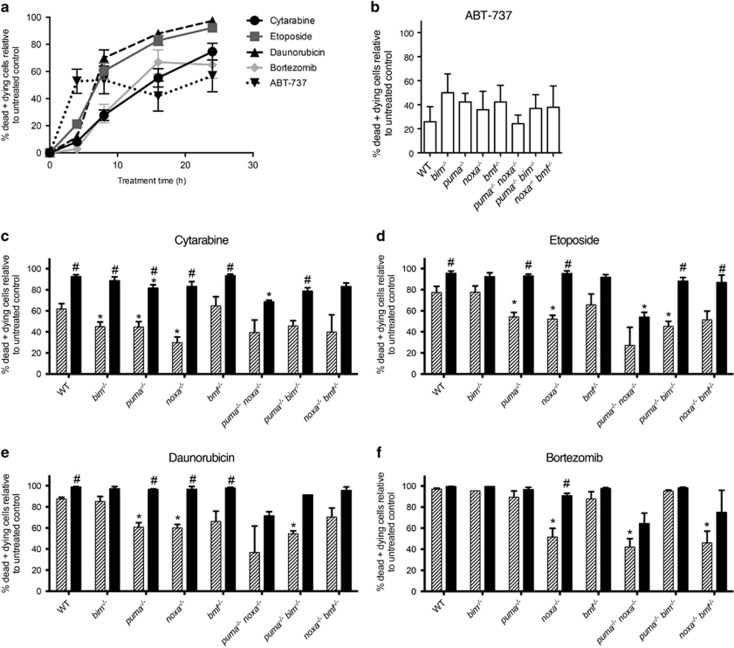
In vitro sensitivity of MLL-AF9 AML cell lines to cytotoxic agents. Drug sensitivity tests were performed using short-term cell lines established from bone marrow of sick primary MLL-AF9 AML mice (Materials and methods section). (a) WT/MLL-AF9 AMLs (n=4) were treated with standard chemotherapeutic drugs cytarabine (300 ng/ml), etoposide (300 ng/ml), daunorubicin (50 ng/ml), bortezomib (5 nM) or BH3 mimetic ABT-737 (1 μg/ml), harvested at 4, 8, 16 and 24 h and analyzed by flow cytometry following staining with annexin V-Alexa Fluor 647 and propidium iodide (dying and dead cells are positive for annexin V or both markers). Results are expressed as percentage of dead and dying cells relative to that of cells cultured in parallel in medium alone. Value shown is mean±S.E.M. (b–f) AMLs of the indicated genotypes were cultured for 16 h in the presence of ABT-737 alone (b); or with cytarabine (c), etoposide (d), daunorubicin (e) or the proteasome inhibitor bortezomib (f), each alone (gray) or in combination with ABT-737 (black). The percentage of dead and dying cells is expressed relative to cells of the same genotype incubated in the absence of drug(s). Values represent mean±S.E.M. Data plotted for ABT-737 alone were pooled from all experiments (n=8 independent lines for WT and n=2–6 independent lines for other genotypes). The number of independent lines used for other drugs±ABT-737 were: WT n=5; bim−/−
n=3, except with bortezomib where n=1; puma−/−
n=3; noxa−/−
n=3; bmf−/−
n=4; puma−/−noxa−/−
n=2; puma−/−bim−/−
n=2; noxa−/−bmf−/−
n=3. P-values were calculated using an unpaired t test with Welch's correction. *P<0.05 between WT AMLs and the indicated BH3-only gene KO AMLs in response to a particular drug or combination; #P<0.05 for drug in combination with ABT-737 versus just the single drug alone for the same genotype